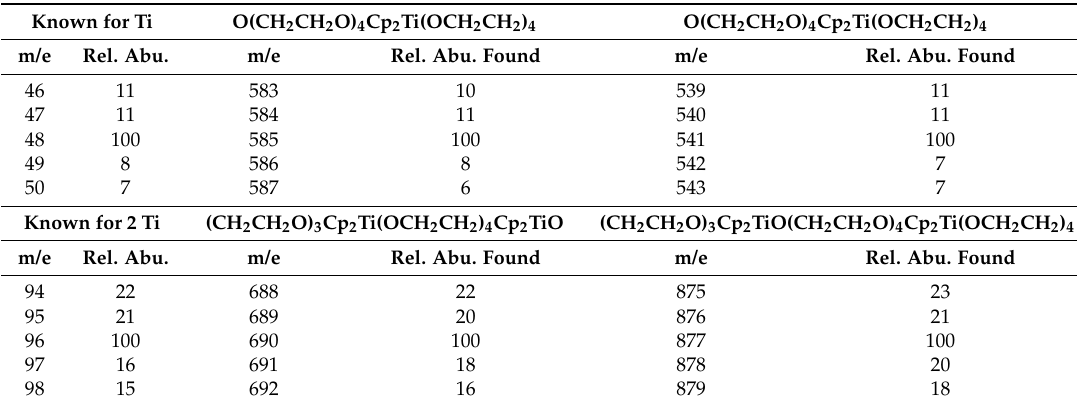
Table 5. Isotopic abundance matches for two ion fragment clusters containing a single titanium atom (top), and two ion fragment clusters containing two titanium atoms per cluster